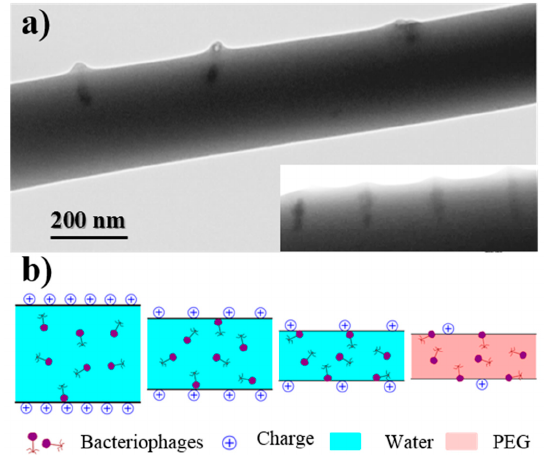
Figure 7. ( a ) TEM micrographs showing the preferential orientation of bacteriophages in the inner surface of the electrospun PEG microfibers obtained from a WF solution. ( b ) Scheme showing the effect caused by the positive charge distribution of the PEG surface on the distribution of bacteriophages.